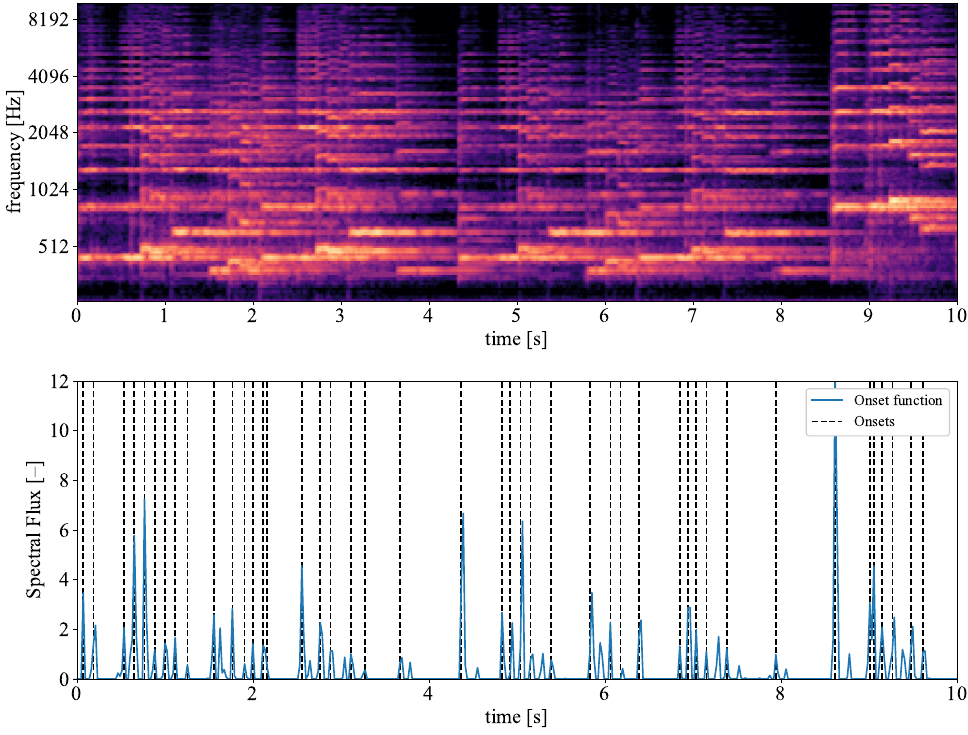
Figure 6. Spectrogram and onset detection function for a solo violin without